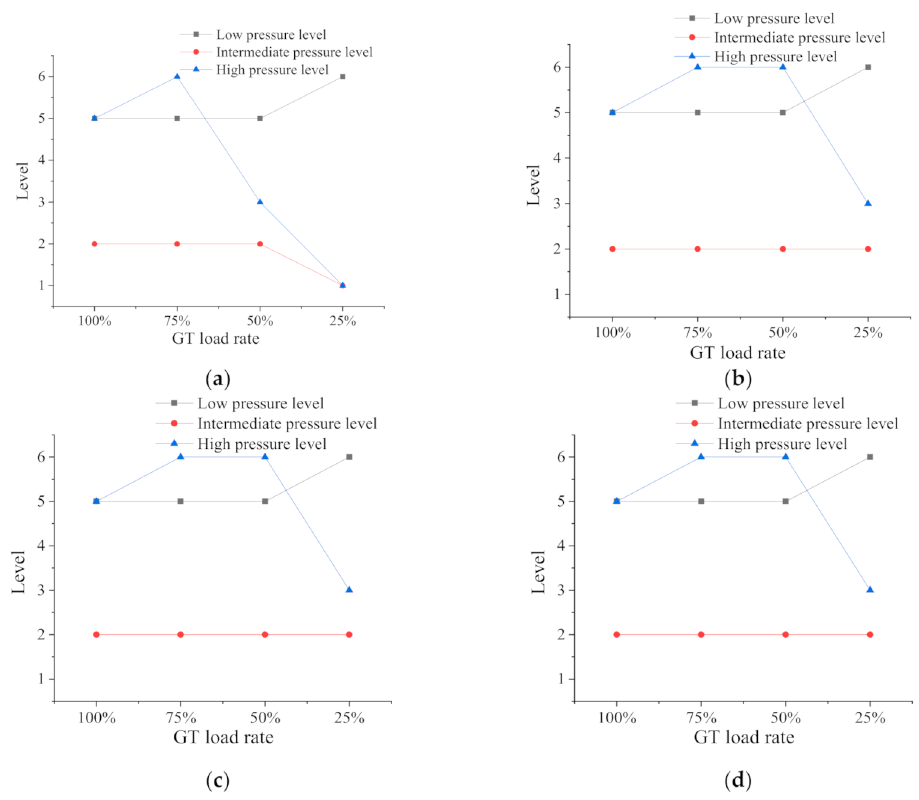
Figure 9. The steam pressure optimal level under all operation strategies: ( a ) IGVT3-F ( b ) IGVT4-F ( c ) IGVT3- 650-F ( d ) IGVT4 gradual